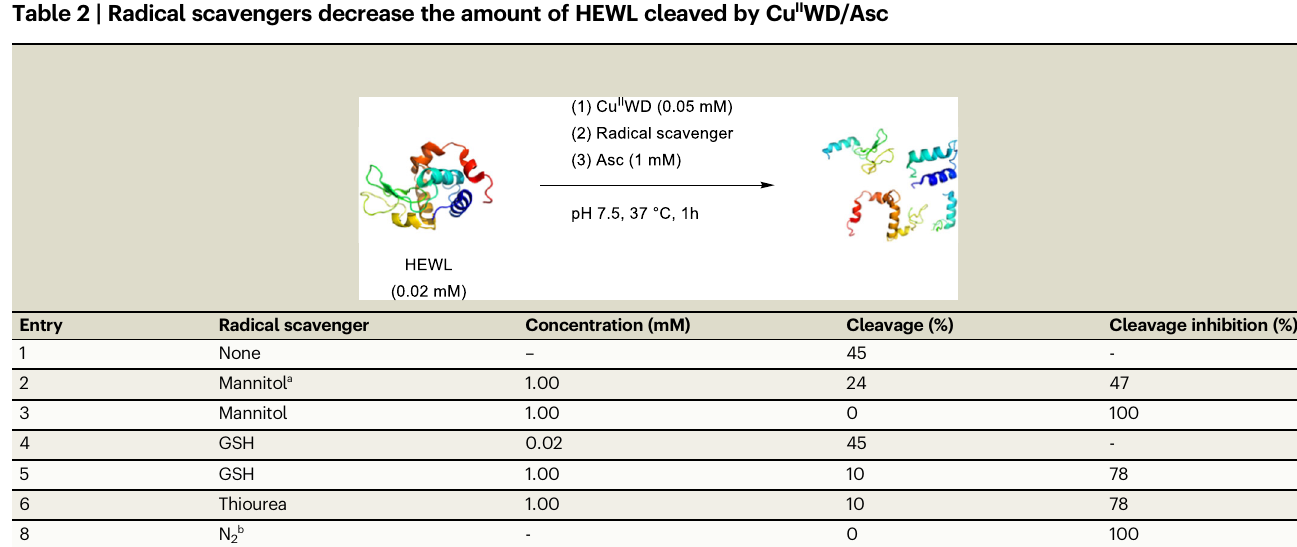
Table 2 | Radical scavengers decrease the amount of HEWL cleaved by Cu II